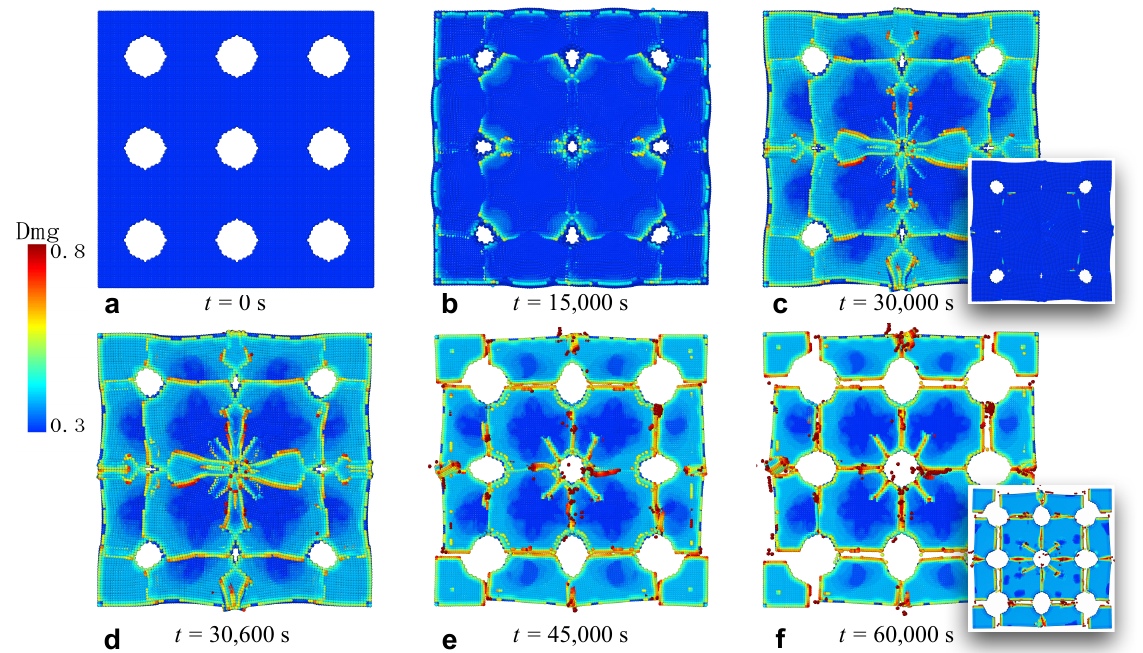
Figure 6. The process of crack formation and propagation in the silicon film pattered with circular holes. The holes were located at 25 µ m, 75 µ m, and 125 µ m in each direction from the corners. The diameter of the holes was 25 µ m. The figures and the insets correspond to the same process of lithiation/delithiation as in the continuous